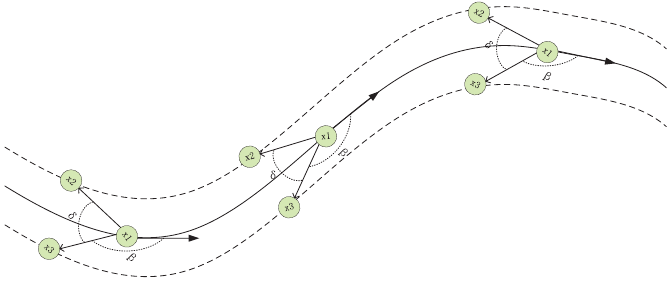
Figure 2. The trajectories of group targets under continuous